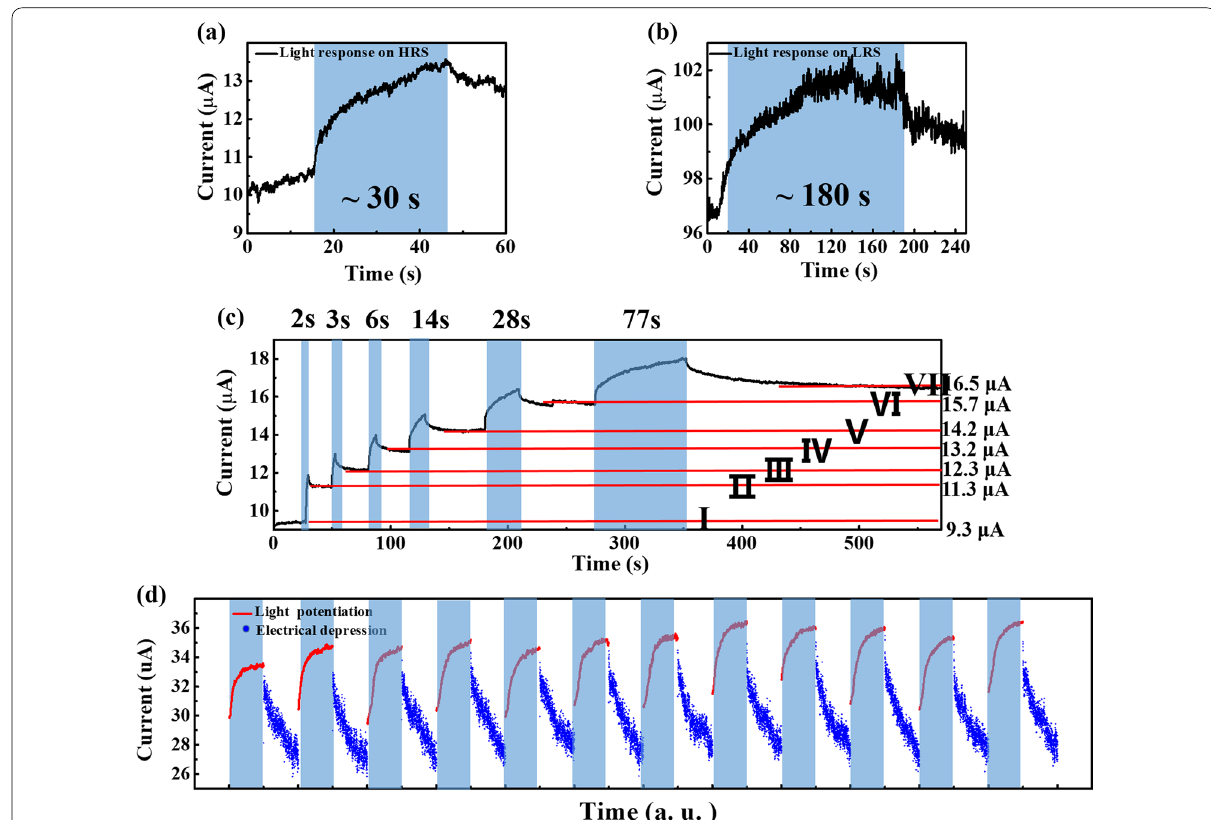
Fig. 4 Current response under the application of 405 nm wavelength light irradiation on a HRS and b LRS. c Multilevel storage realized by light irradiation. d Optical potentiation and electrical depression characteristics simulated by optoelectronic artificial